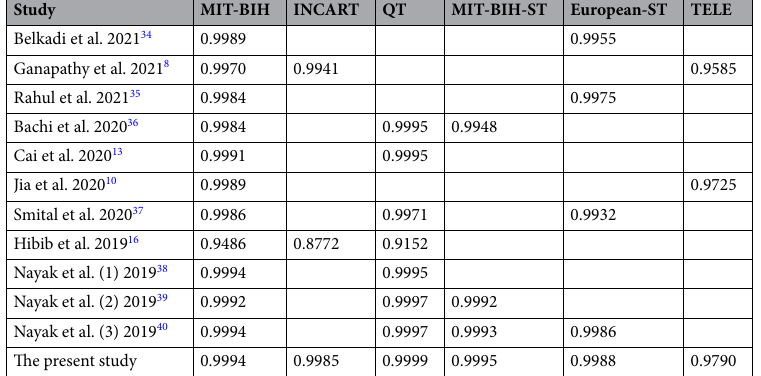
Table 5. F1 scores of various databases.